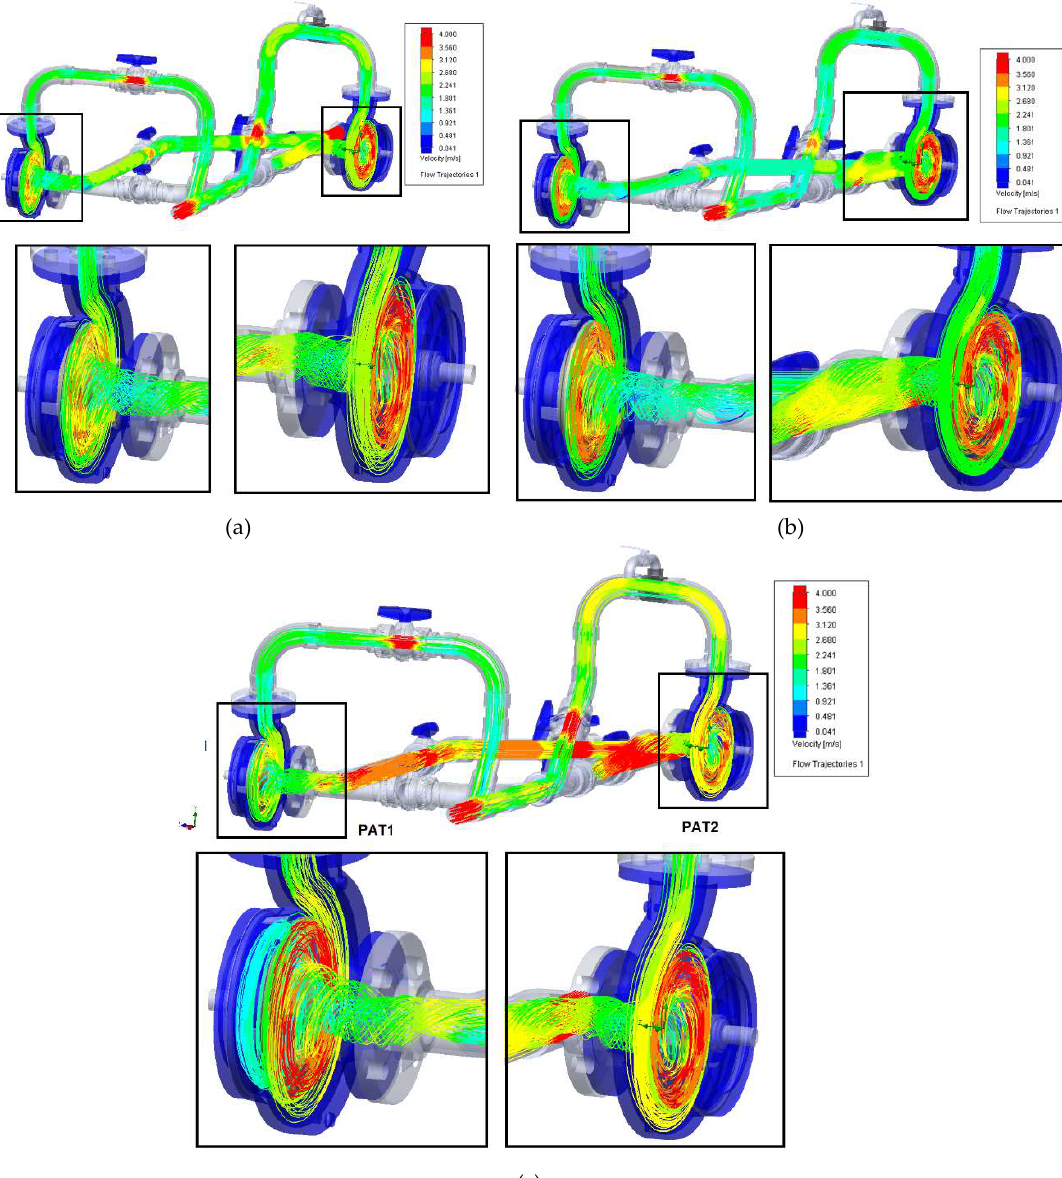
Figure 13. Velocity streamlines for: ( a ) Q = 5.80 L/s with N1 = 400 rpm and N2 = 700 rpm; ( b ) Q = 6.70 L/s with N1 = 440 rpm and N2 = 735 rpm; ( c ) Q = 7.20 L/s with N1 = 440 rpm and N2 = 735 rpm (with PAT1 on the left, PAT2 on the right).